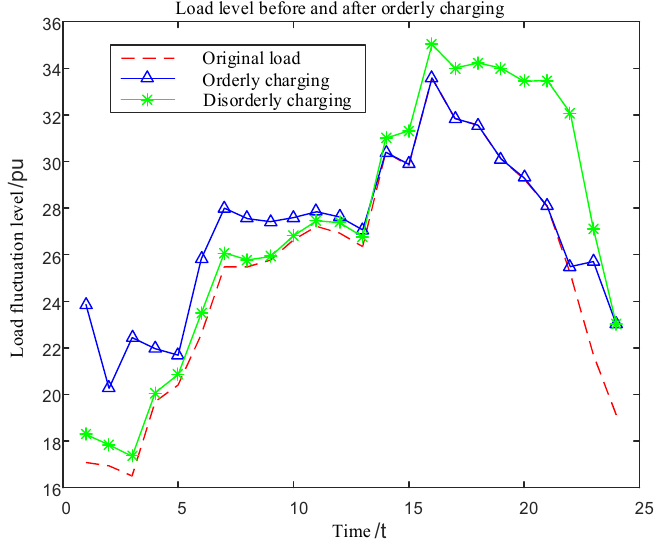
Figure 13. Load level changes before and after EV orderly charging.